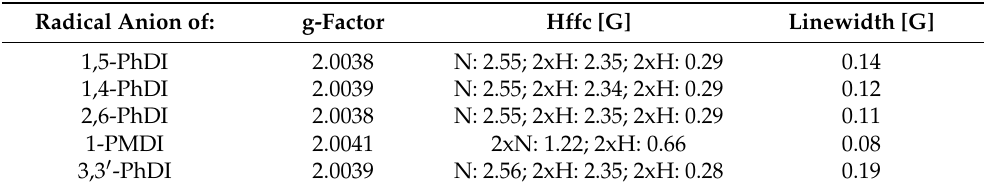
Figure 3. Experimental (black line) and simulated (red dashed line) EPR spectra of electrochemically generated radical anions of 1-PMDI ( a ) and 1,4-PhDI ( b ) in 0.1 M Bu 4 NPF 6 /DCM electrolyte. Fitting parameters are listed in Table 4. Table 4. Fitting parameters for simulation of EPR spectra of radical anions, together with g-factor estimated from experimental spectra.